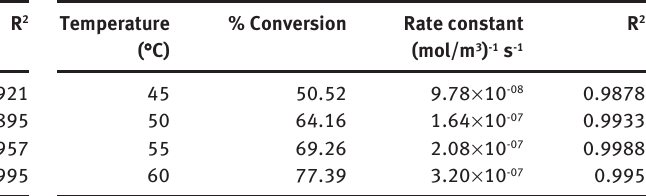
Table 4 Kinetic analysis for the effect of